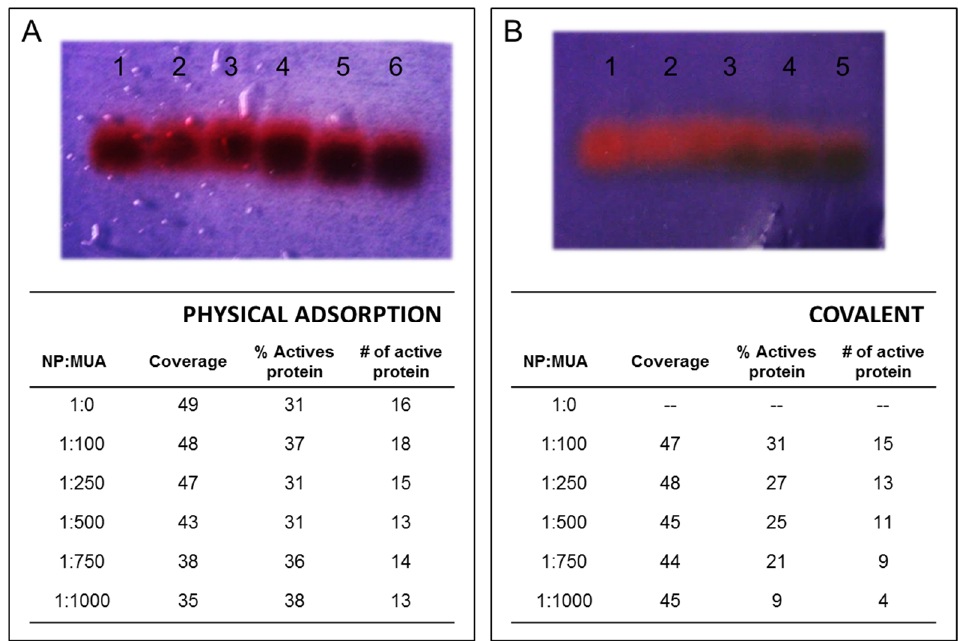
Figure 8. Effect of surface chemistry of AuNP-linked r Vu FeSOD on the superoxide dismutase activity assay outcome. ( A ) Physical adsorption: AuNP– Vu FeSOD activity gel for different NP:MUA stoichiometry and in the table, data of coverage, percentage of remaining superoxide dismutase activity, and number (#) of active proteins on the NPs. ( B ) Covalent attachment: NP– Vu FeSOD activity gel for different NP:MUA stoichiometry and in the table, data of coverage, percentage of remaining superoxide dismutase activity, and number of active proteins on the NPs.